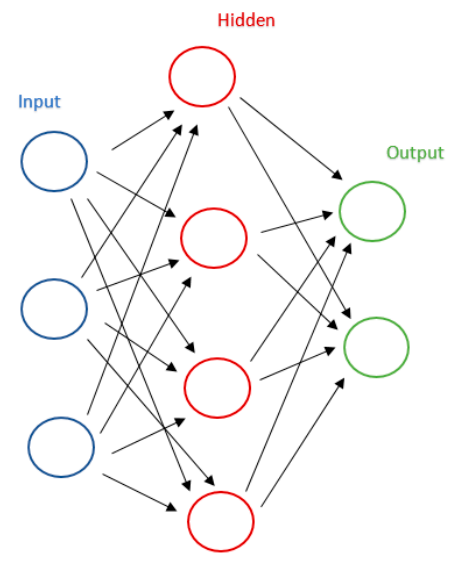
Figure 3. An example of three-layers neural networks.